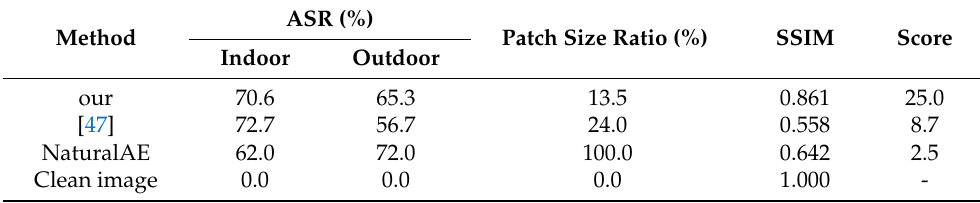
Table 2. The performance of our method in the physical domain and comparison with other methods.